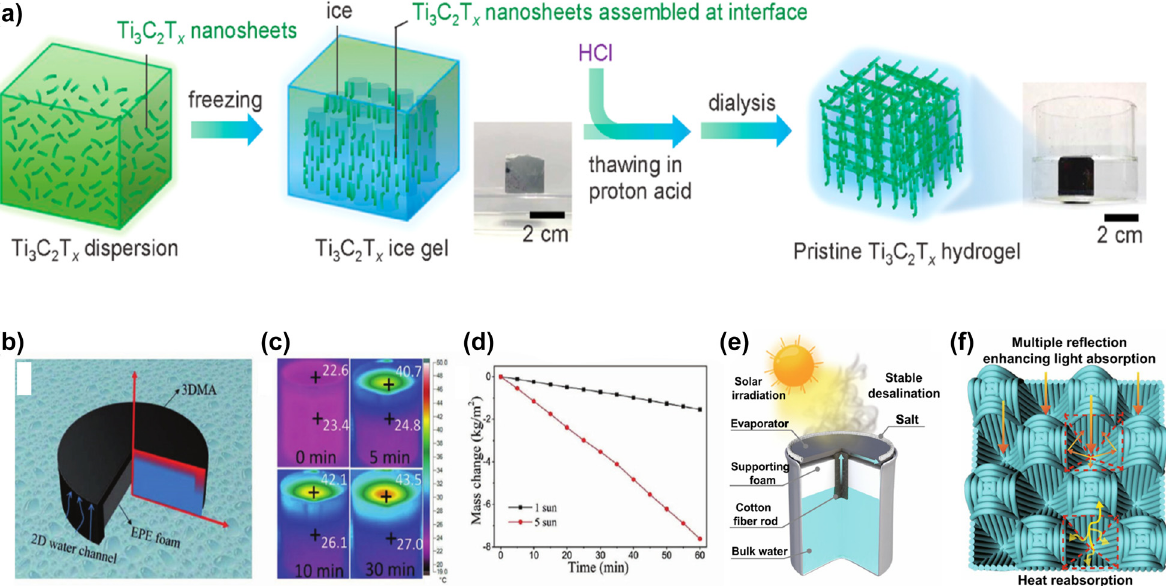
C T hydrogel. Figure 13: The structure and properties of Ti 3 2 x C T hydrogel, which includes ice-template preassembly and thawing in HCl solution. (a) Two-step approach to prepare the pristine Ti 3 2 x Reproduced with permission [178]. Copyright 2020, American Chemical Society. (b) Schematic illustration of the 3DMAs embedded with EPA foam as the thermal insulation layer. (c) Infrared images of water and 3D MA surfaces under 1 Sun illumination of 0, 5, 10, and 30 min. (d) The mass change of water for 3DMA with EPA foam under the solar illumination of 1 Sun and 5 Sun, respectively. Reproduced with permission [179]. Copyright 2019, Royal Society of Chemistry. (e) Schematic diagram of MXene-decorated 3D honeycomb fabric-based solar evaporator for desalination. (f) Schematic illustration of the 3D honeycomb-structured fabric for light absorption and heat reabsorption. Reproduced with permission [75]. Copyright 2021, The